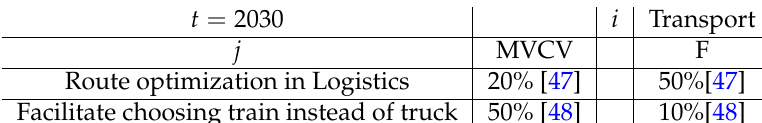
Table 13. Smart Transport saving